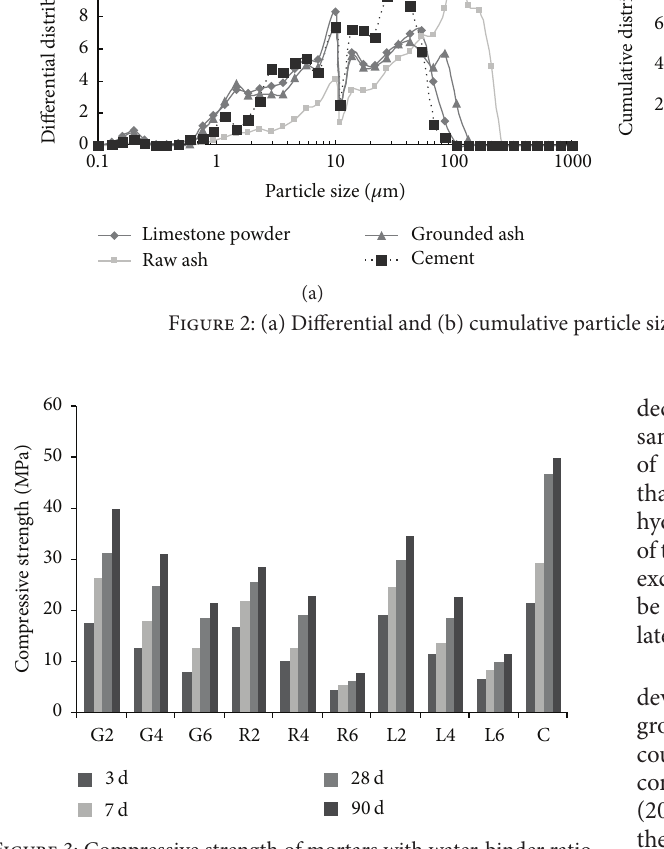
Figure 3: Compressive strength of mortars with water-binder ratio of